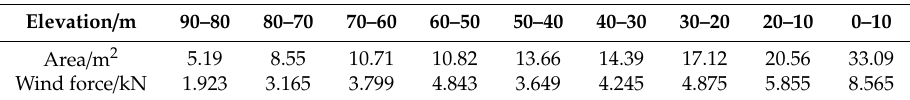
Table 1. Wind force of OIMM (meteorological mast).